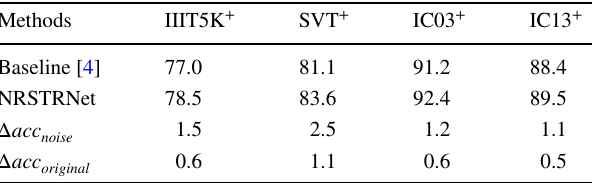
Table 5 Comparison of text recognition accuracy of models on blur test sets